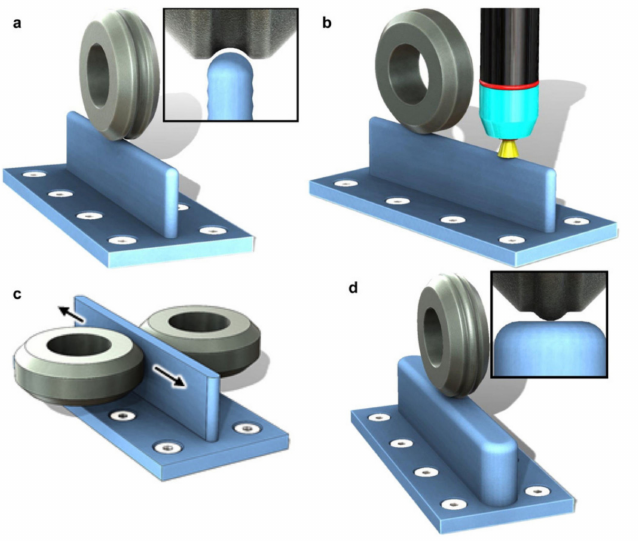
Figure 10. Schematics of possible rolling methods: ( a ) vertical with a profiled roller; ( b ) in situ rolling; ( c ) pinch rolling and ( d ) rolling with an inverted profile roller